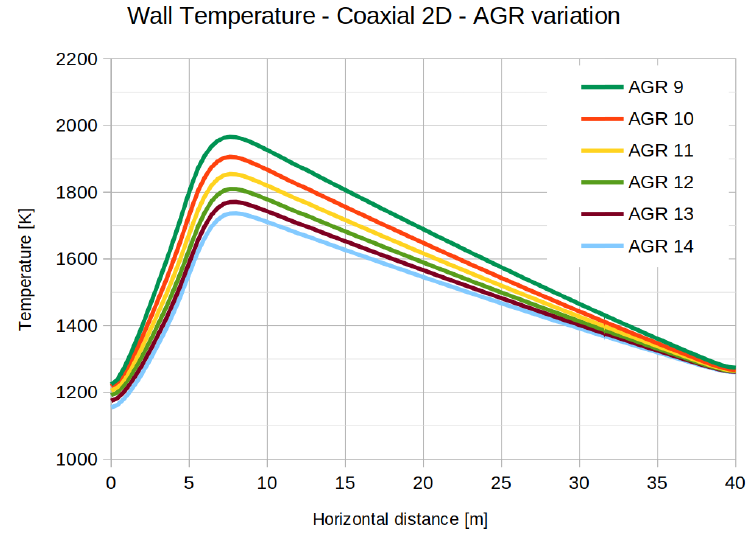
Figure 11. Computed wall temperature in the longitudinal direction of the kiln for different AFR’s.